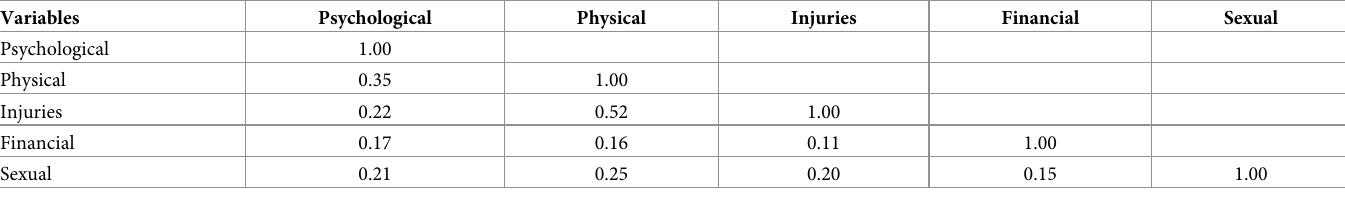
Table 4. Types of lifetime abuse: Coefficients of the intercorrelation matrix a .